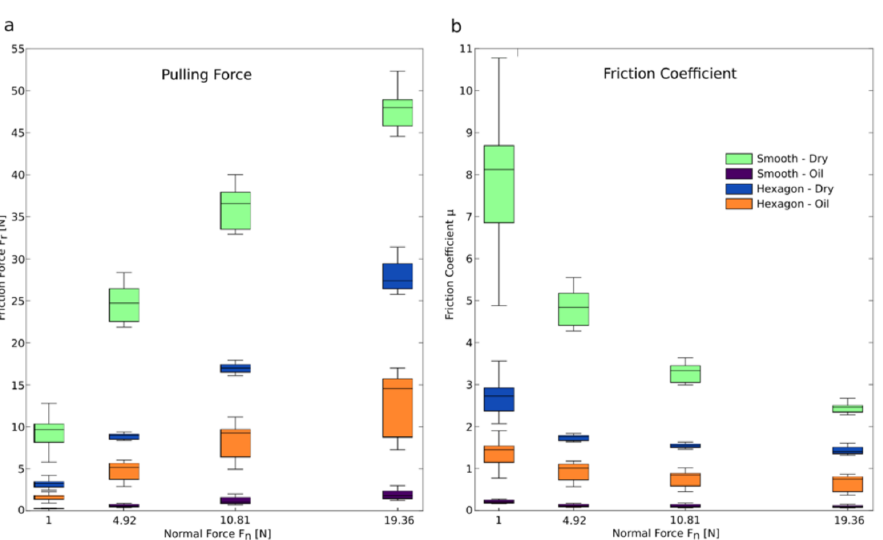
Figure 3. Friction performance of the smooth and hexagon GMFP on dry and oily substrate. ( a ) Measured friction force, ( b ) resulting friction coefficient. The boxes display the median and 25 and 75 percentiles with the whiskers indicating the most extreme data